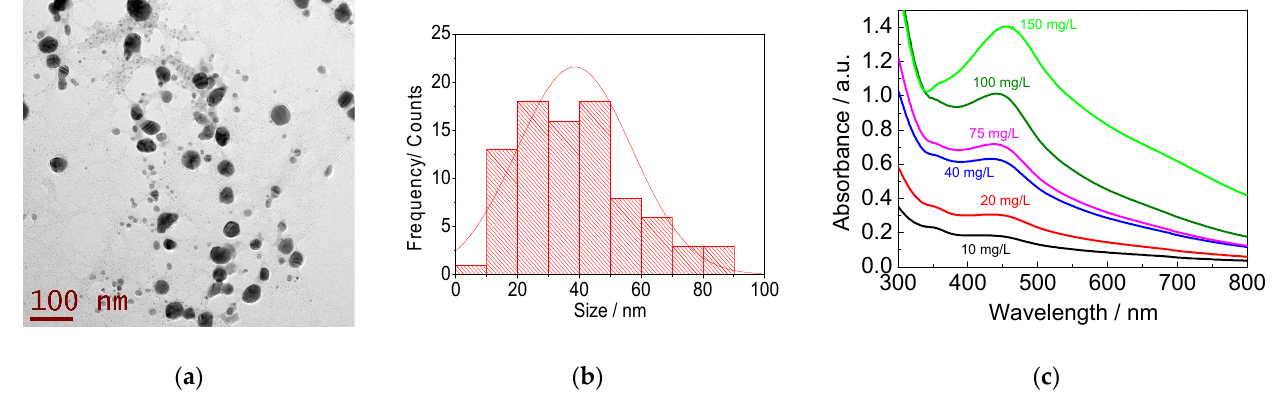
Figure 1. TEM and UV-Vis analysis of the AgNPs: ( a ) micrographs of the AgNPs obtained with the Geranium extract observed with a transmission microscope; ( b ) particle size distribution obtained from the micrograph; ( c ) UV-VIS absorption spectrum for the AgNPs at different concentrations.